Question: What type of chart is this?
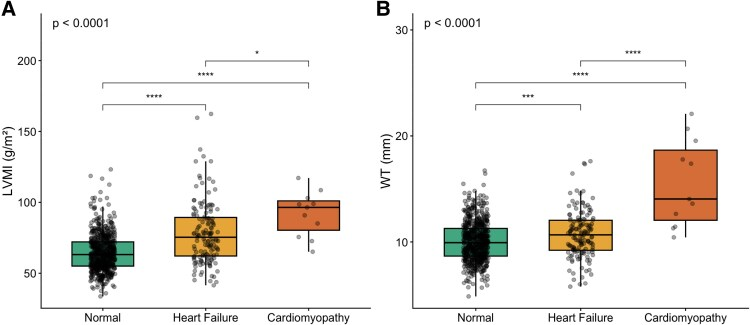
Answer: box